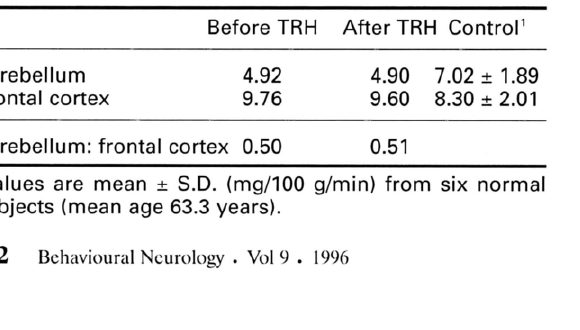
TABLE I. Mean values and ratios of metabolic rate for glu cose in cerebellum and frontal cortex before and after TRH treatment TABLE II. Areas of sway of gravity center of the patient